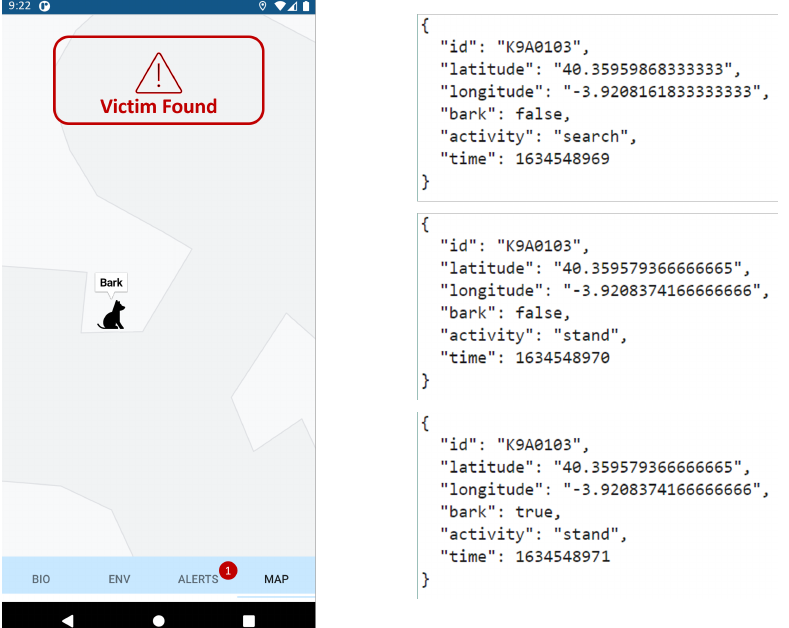
Figure 15. Mobile screenshot displaying generated alert in 1st SaR scenario ( left ), and corresponding KAFKA messages, with last one triggering alert rule ( right